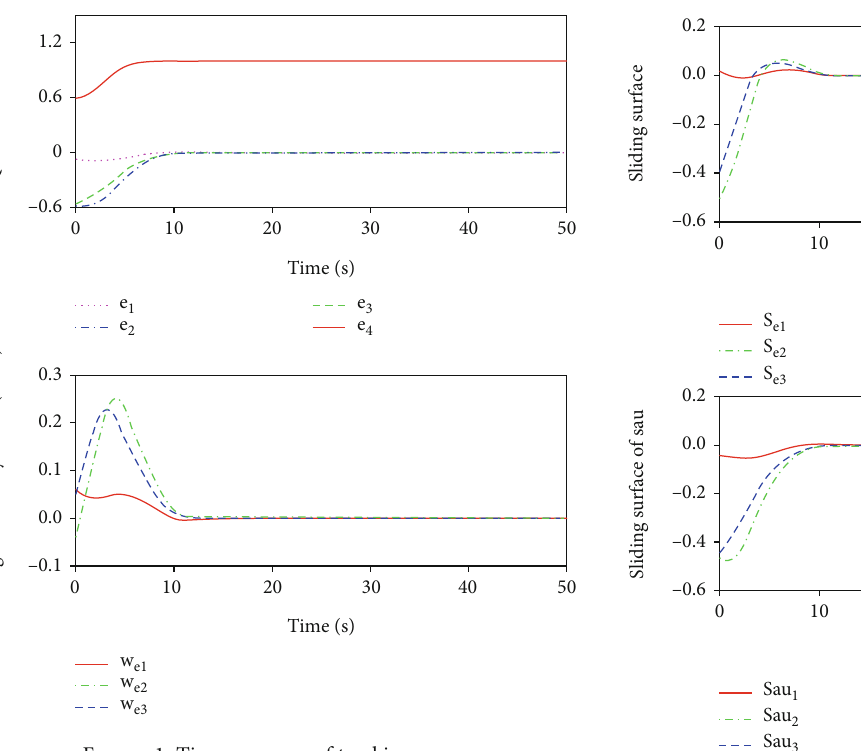
Figure 1: Time response of tracking errors.